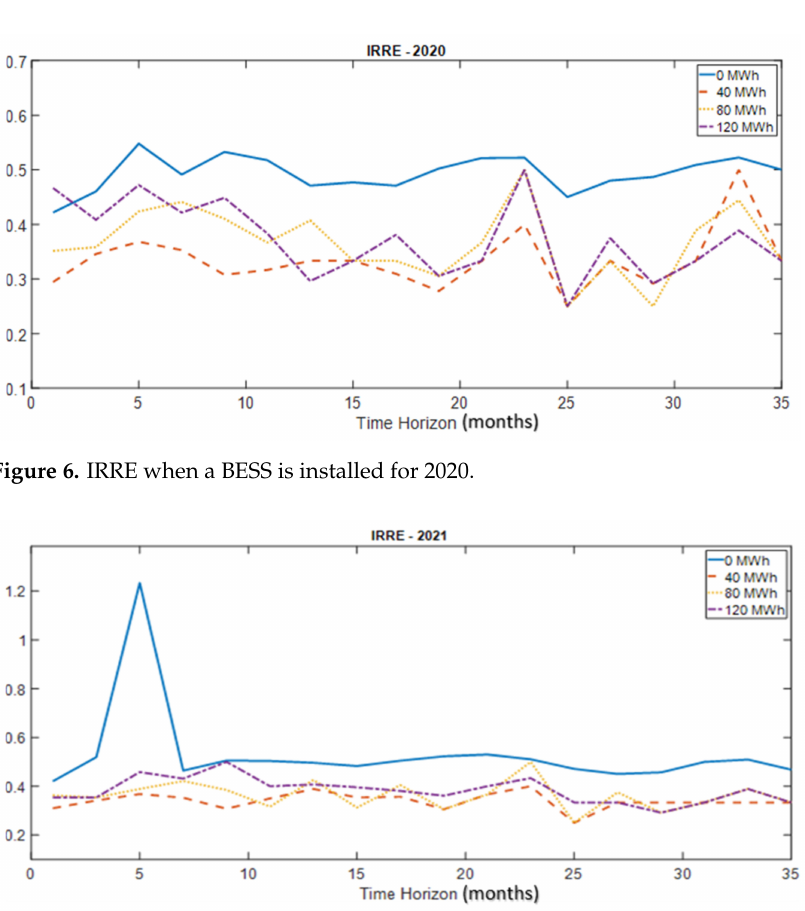
Figure 7. IRRE when a BESS is installed for